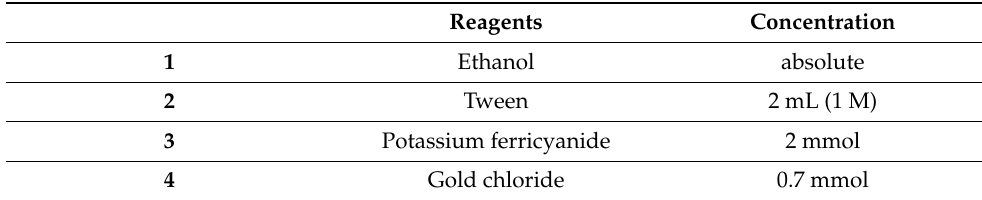
Table 1. Used reagent’s